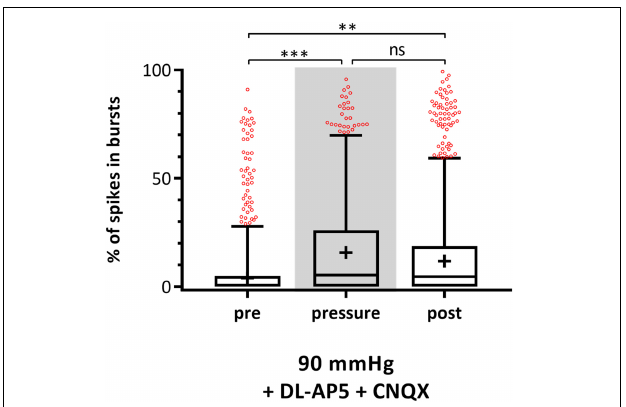
FIGURE 7 | Effect of glutamate receptor blockers on RGC bursting behavior under 90 mmHg. The number of spikes in bursts [%] before (pre), during (pressure), and after (post) pressure stress of 90 mmHg in addition of the glutamate receptor blockers DL-AP5 and CNQX is shown. Data are presented as box and whisker (min to max) plots. Outliers calculated by ROUT ( Q = 0.1%) are shown as red circles. Mean values of the cleaned data are shown as + . Significant values are indicated by asterisks. Not significant values are labeled with ns. One-way ANOVA with post hoc Tukey’s test was performed with GraphPad Prism Software version 7. F (2, 1365) = 6.814, p = 0.0011. n retinae = 3, n cells = 229, n recordings = 48.